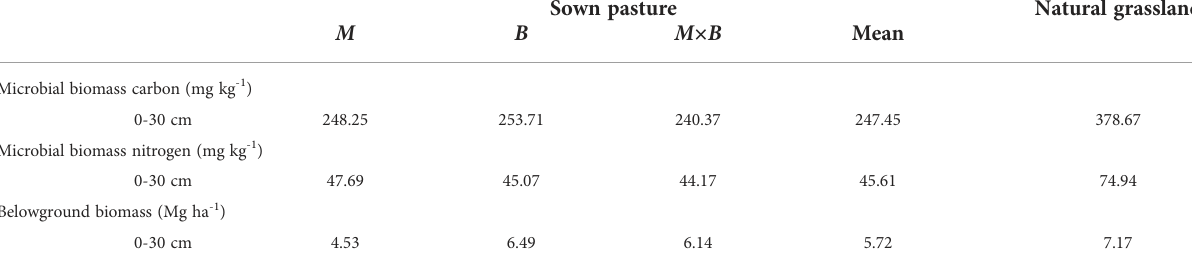
TABLE 4 Vertical variations and trends in soil biological properties over soil depth in sown pastures versus the natural